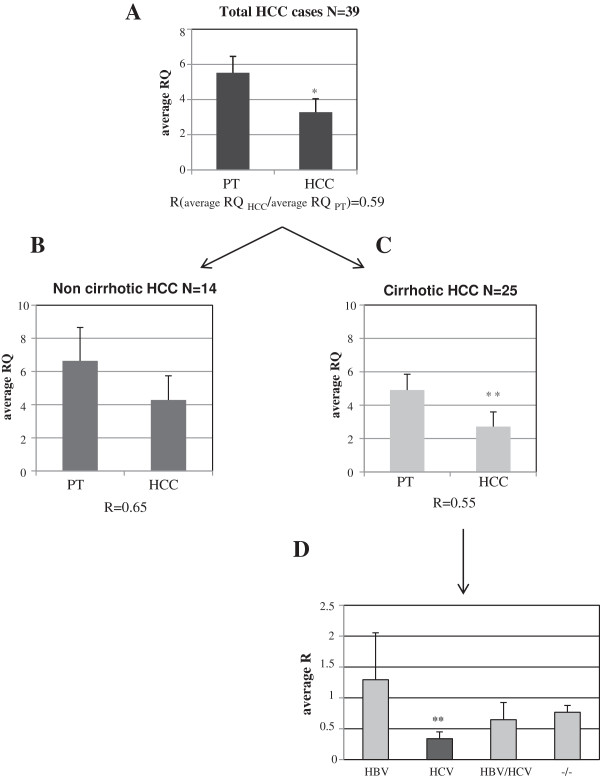
miR-193a expression analysis by Real-Time PCR in tumoral tissues from biopsy samples of HCC patients. (A) The level of mature miR-193a is generally down-regulated in HCC compared with the corresponding PT tissues average RQPT = 5.53 ± 0.93, RQHCC = 3.27 ± 0.77; p < 0.05. (B) miR-193a expression level in HCCs developed in non-cirrhotic and (C) cirrhotic liver. (D) Cirrhotic HCCs stratified on the basis of the type of hepatitis viral infections. The class of HCV showed the lowest average R (average R = 0.338; p < 0.01 in a t-Test analysis for single group mean with expected value = 1).